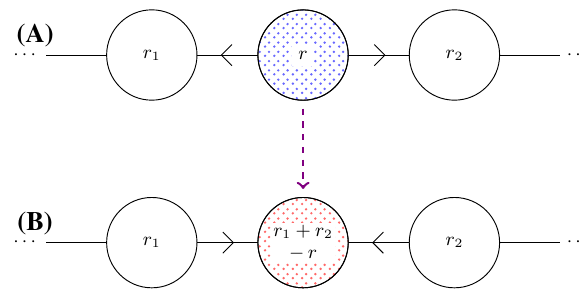
Fig. 6 2d Seiberg duality on a node with only chiral fundamental mat- terrealizedbyadjacent2dgaugenodes.Inthiscasetherearenomesonic fields introduced in this